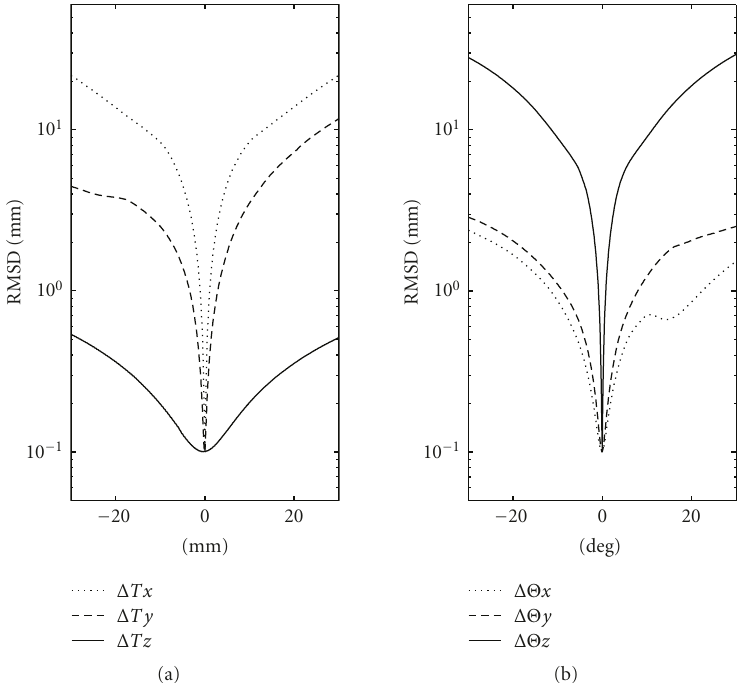
Figure 3: The root mean square distance RMSD plotted against the perturbation on the translations (a) and rotations (b) for the humerus bone. The RMSD forms a cusp around its